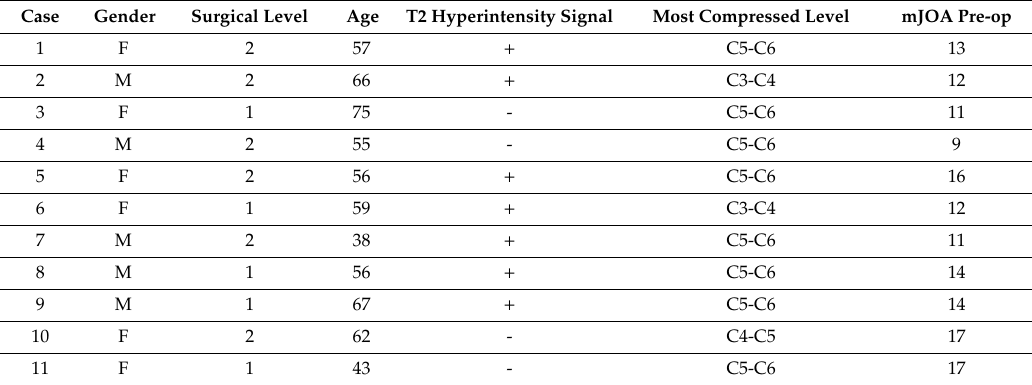
Table 1. Demographic, MRI characteristics and surgical level.